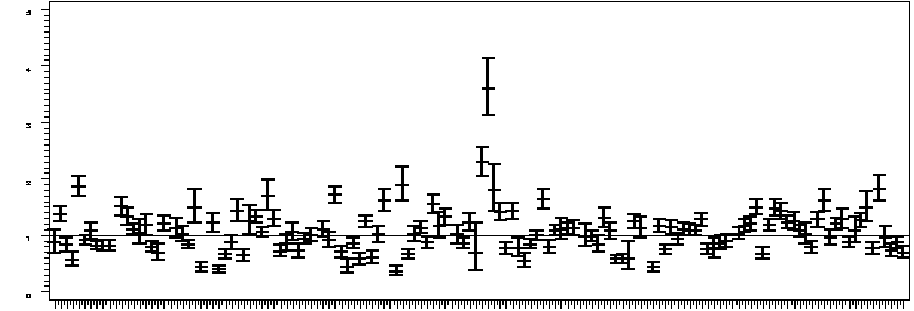
Figura 5 – y 5 a ritorno in sala